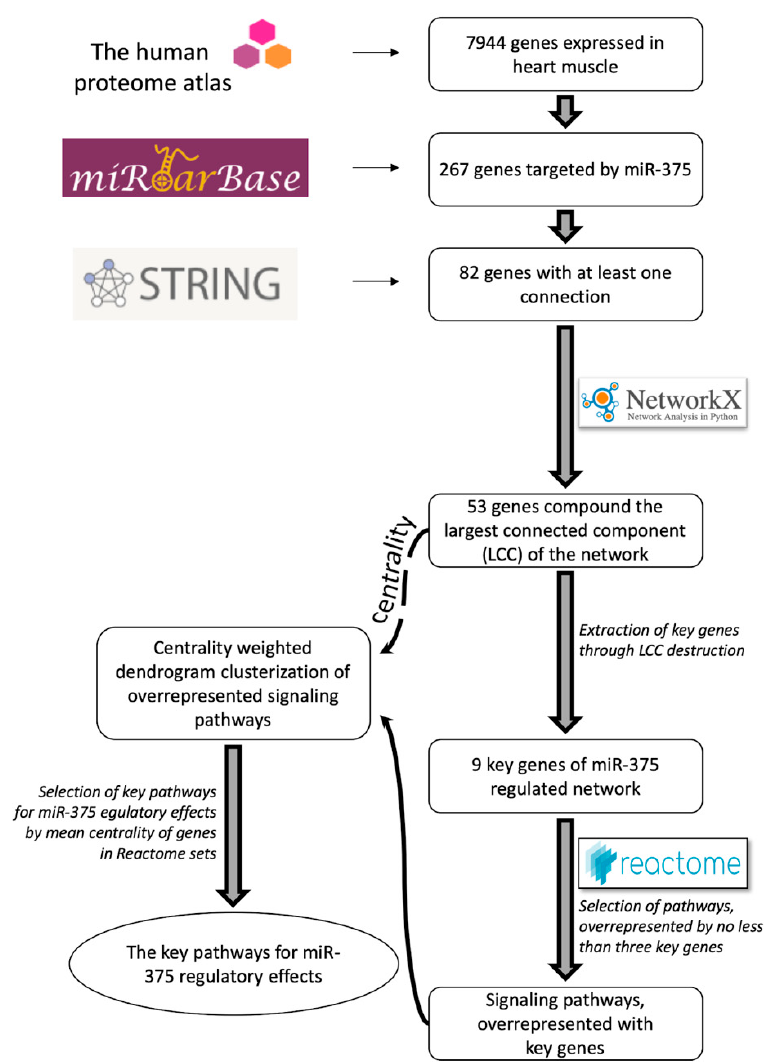
Figure 3. A schematic workflow of prediction of miR-375 function in heart muscle.